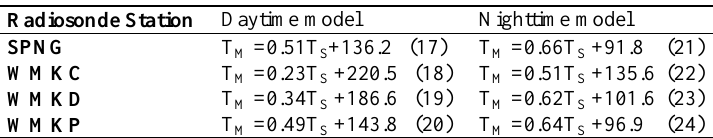
Table 6. The daytime and nighttime T M models have been developed for each radiosonde station. From temporal analysis, it was found that the relationship of T M -T S is always higher; >0.5 for the night observation. Meanwhile, the spatial location also indicates that the T M -T S daytime has weak relationship at east coast compared to the west